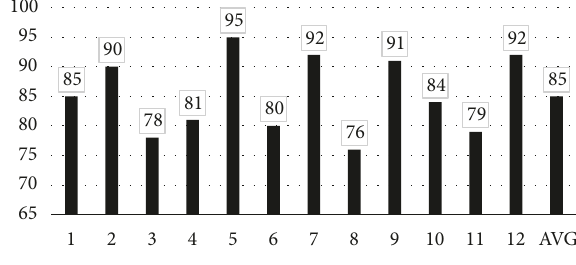
Figure 14: Evaluation of decision